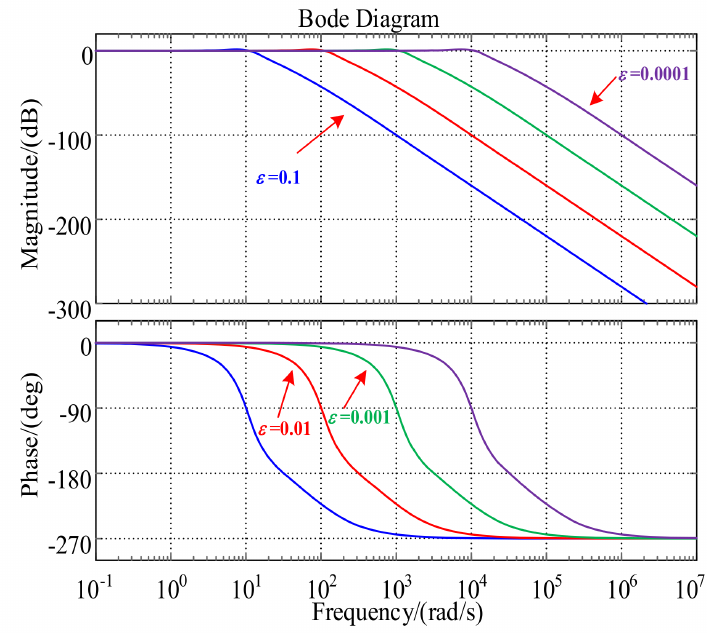
Figure 6. Bode diagram of the integral chain